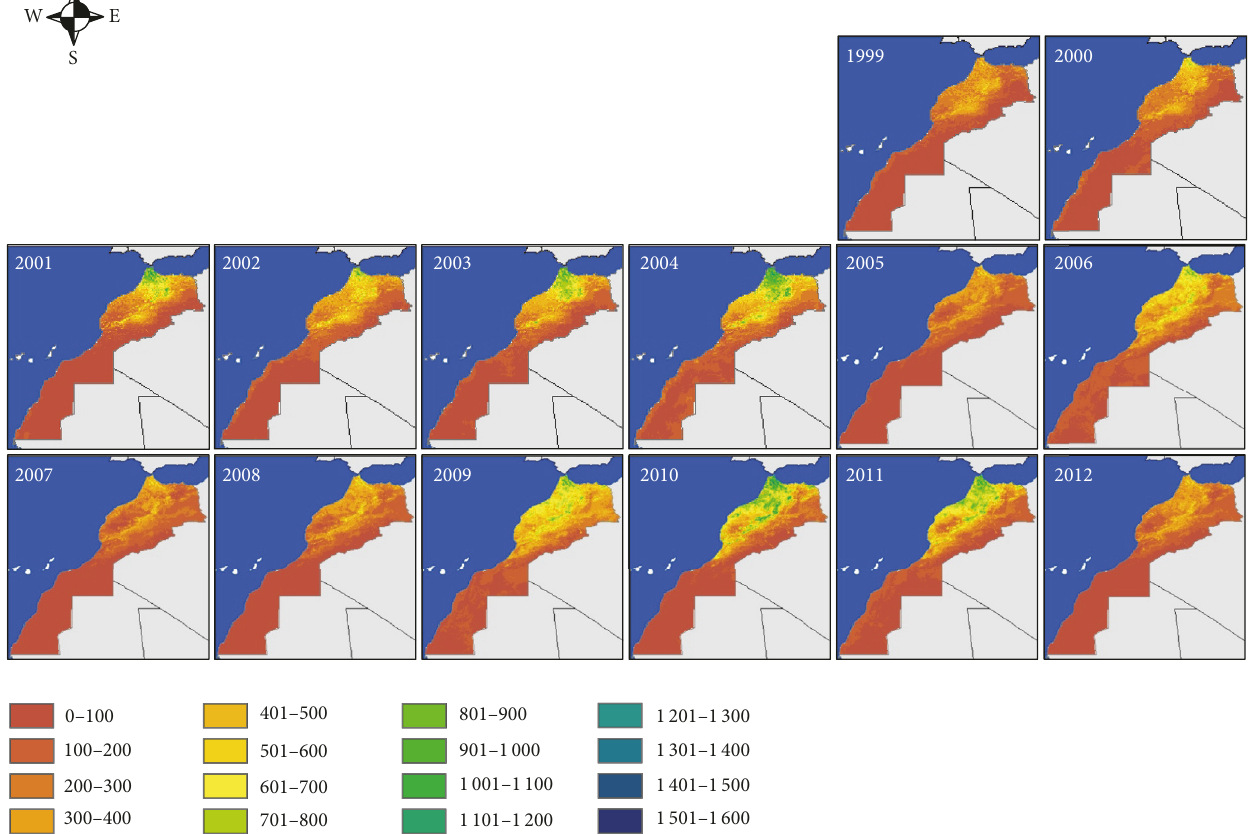
Figure 10: Spatiotemporal distribution of downscaled and calibrated precipitation (in mm) over Morocco (1999–2012) at a spatial resolution of 1km, using Group